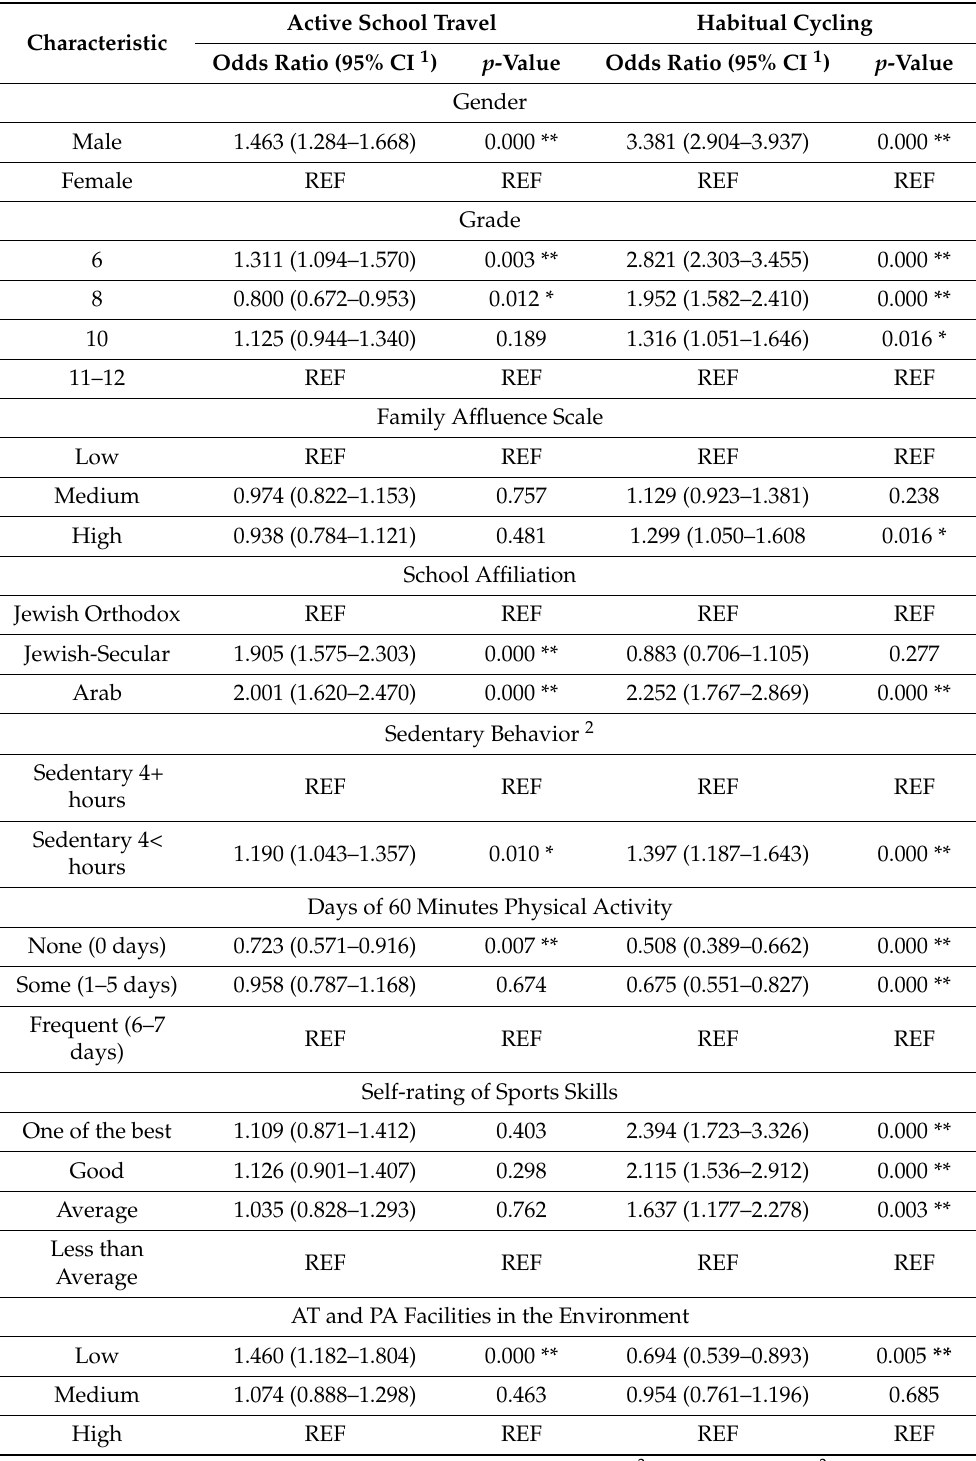
Table 2. Key results for logistic regression models, active school travel and habitual cycling.